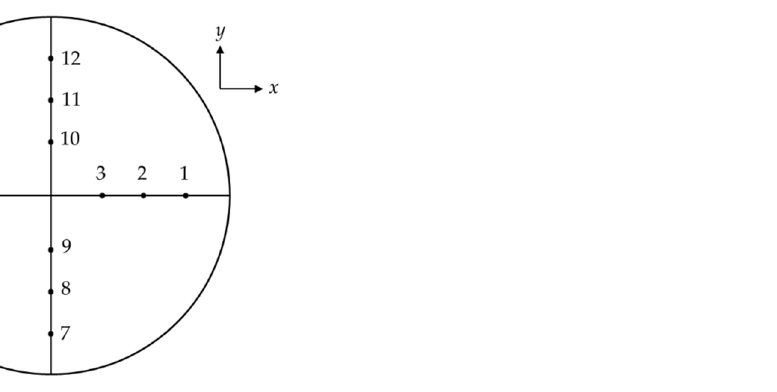
Figure 9. Large-aperture channel sealing experimental model.